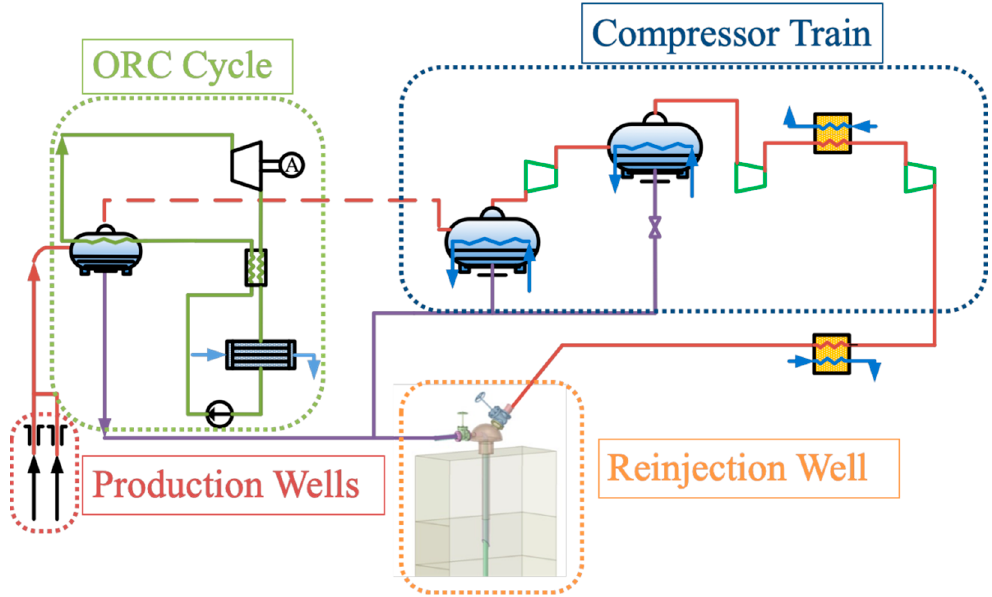
Figure 3. Schematic of the reinjection well and the process of NCG injection into the downward flowing water.